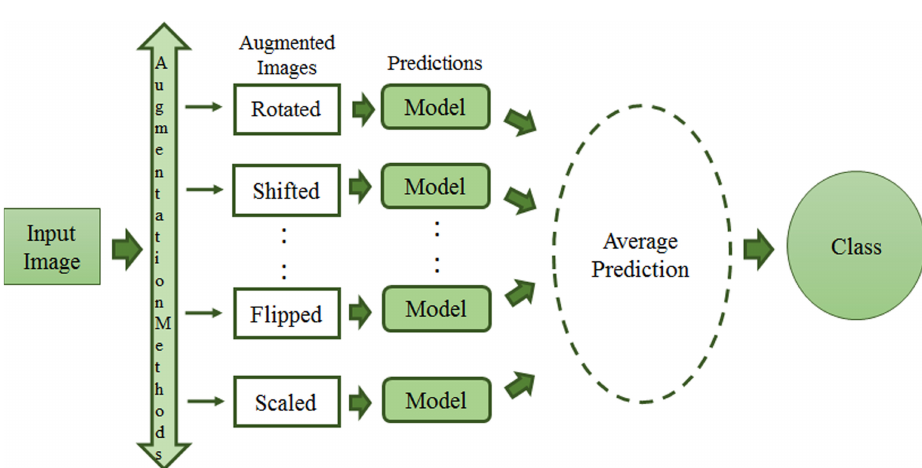
Figure 12. Test-time data augmentation